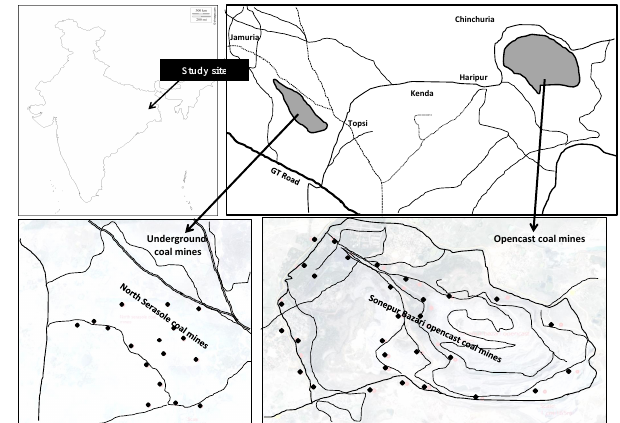
Figure 1. Location map of the study